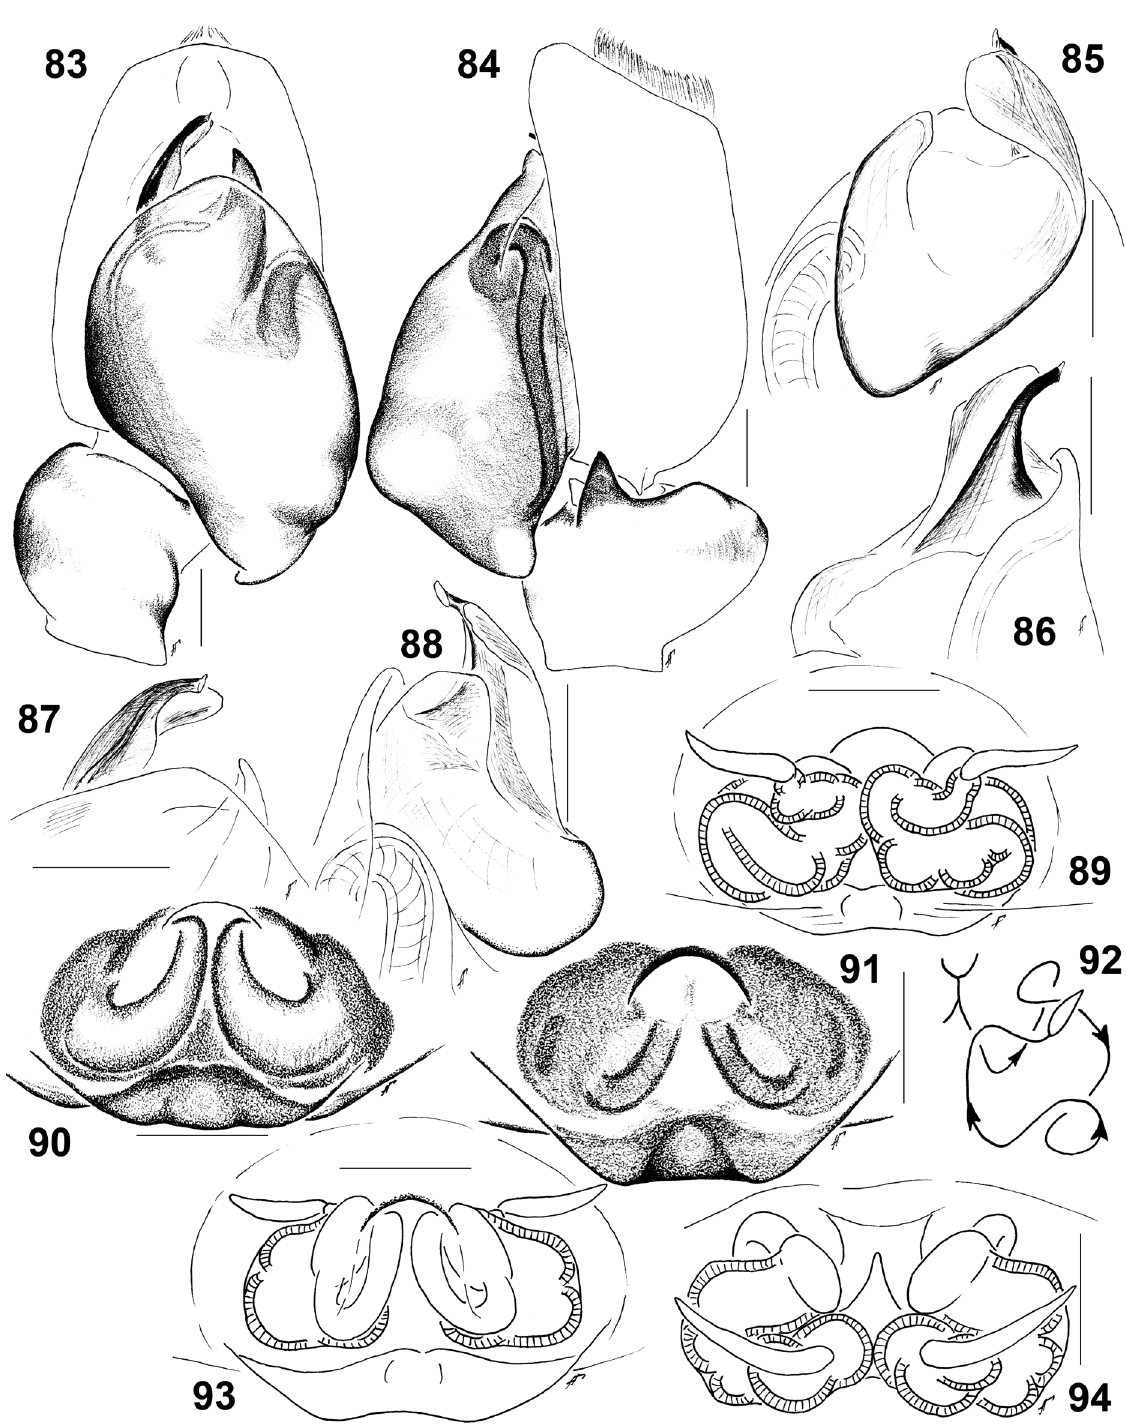
Figs 83–94. Manzuma kenyaensis (Dawidowicz & Wesołowska, 2016) gen. et comb. nov., ♂ from Kwaisagat (MMUE G 7572.12) (83–88), ♀ from Kamatira (MMUE G7572.11) (90) and Kwaisagat (MMUE G 7572.13) (89, 91–94). 83–84 . Male palp. 83 . Ventral view. 84 . Retrolateral view. 85– 88 . Embolic division. 85 . Dorsal view. 86 . Prolateral view. 87 . Ventral view. 88 . Retrolateral view. 89 . Spermathecae, dorsal view. 90–91 . Epigyne, ventral view. 92 . Diagrammatic course of the insemination ducts. 93–94 . Spermathecae. 93 . Ventral view. 94 . Apical view. Scale bars: 0.1